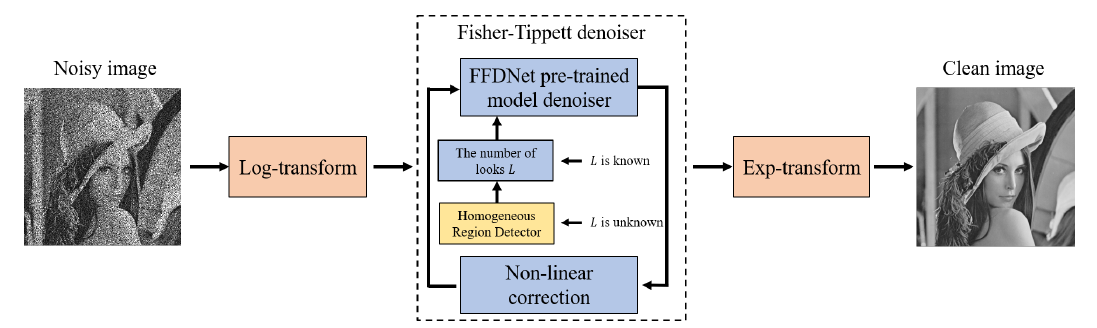
Figure 3. The framework of MuLoG-FFDNet filter for SAR